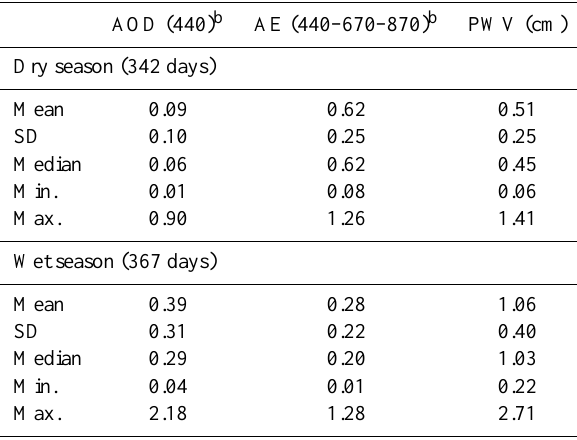
Table 4. Statistics of AOD, AE, and PWV from October 2006 to